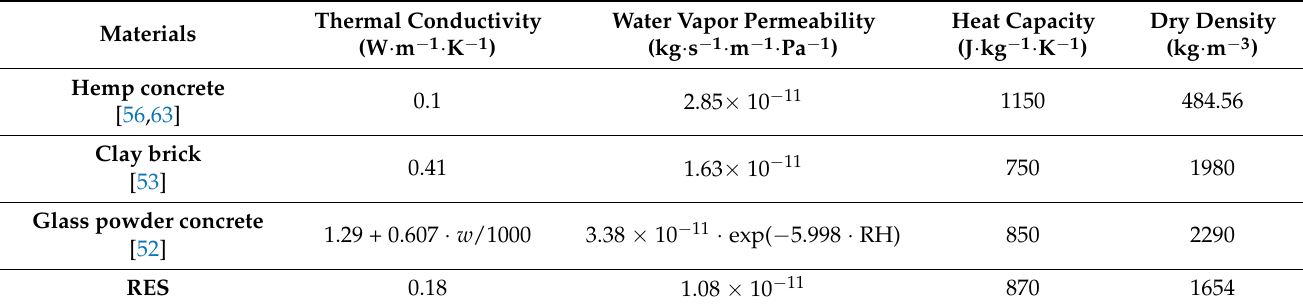
Table 2. Hygrothermal properties of the studied materials.